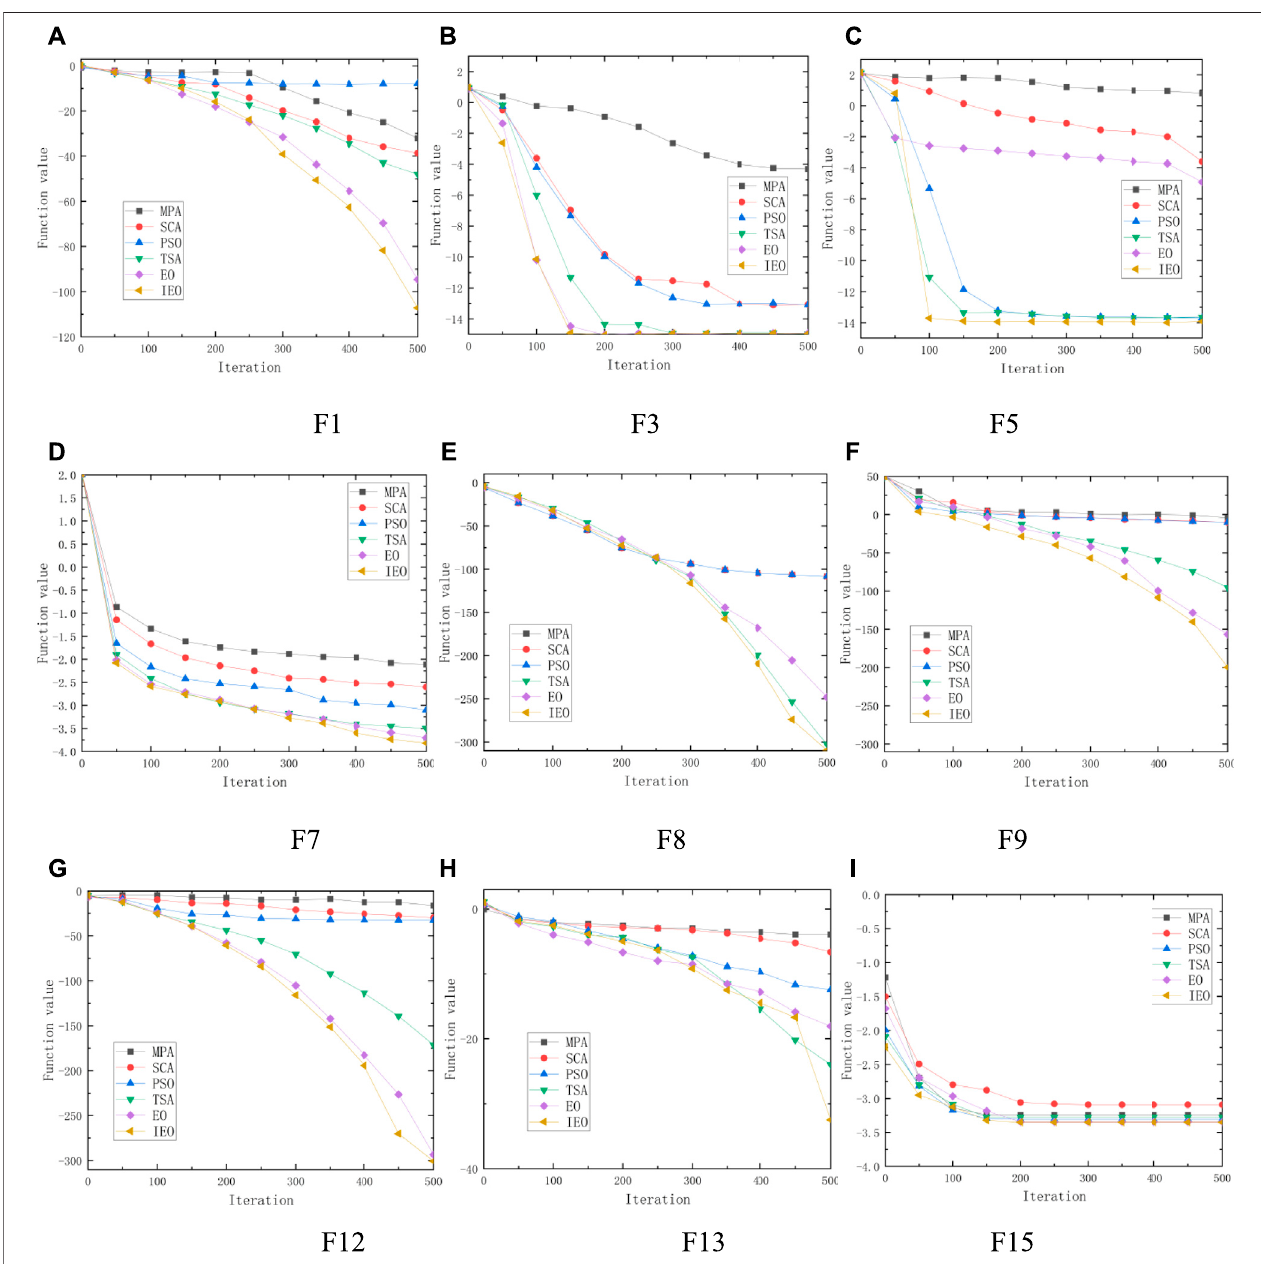
FIGURE 3 | Average convergence curve of nine test functions. Graphs showing the convergence of solution at every iteration on test functions using IEO and fi ve classical algorithms.